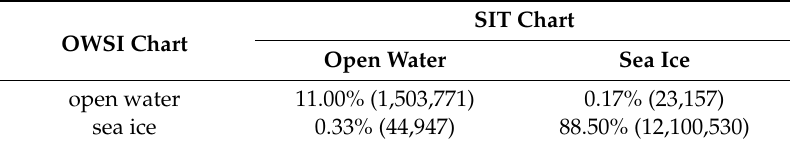
Table 3. Contingency table for the open water vs. sea ice classification in the OWSI charts processed to 1 km pixel size and the sea ice thickness (SIT) charts processed to open water and sea ice classes. The comparison period is March–April 2016. Numbers in brackets show the amount of 1 km pixels. SIT OWSI Chart